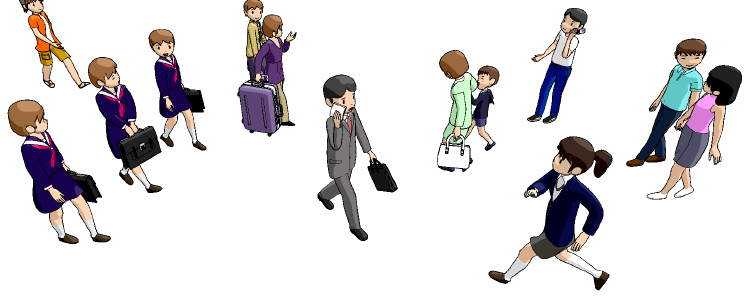
Figure 1. Which pedestrians are in a group? It is hard to tell from snapshots since traditional image based methods do not apply to surveillance footage. Trajectories are an important clue of group